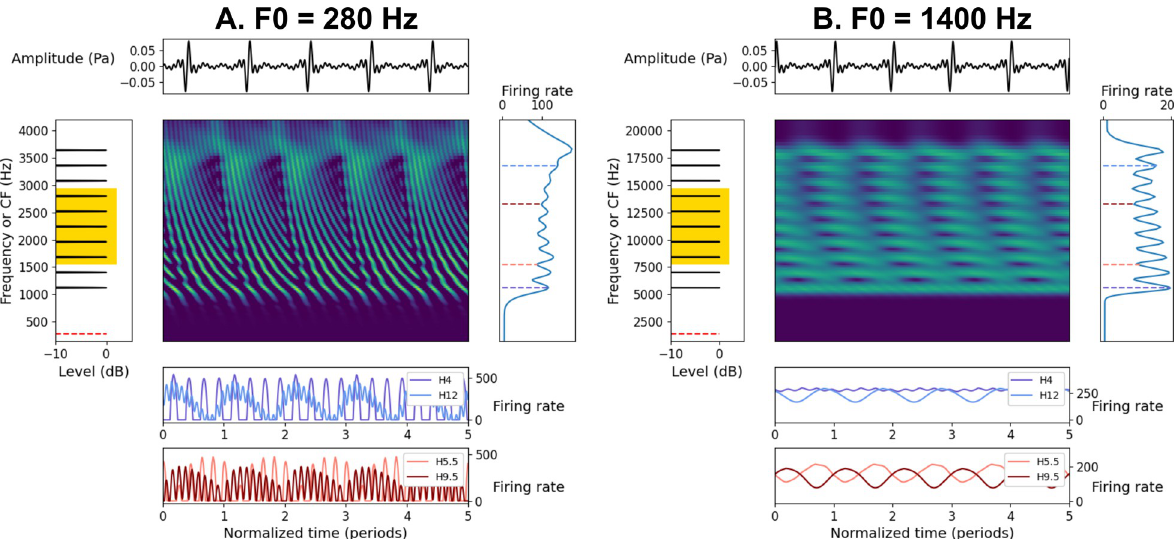
Fig 1. Representation of complex tones in a simulated auditory nerve. (A). Simulated responses of a population of high-spontaneous-rate auditory-nerve fibers [52] for five periods of a sine-phase HCT composed of harmonics 4–13 at a level of 50 dB SPL per component and an F0 of 280 Hz. The middle panel shows a “neurogram”, or a plot of instantaneous firing rate as a function of time and characteristic frequency. In the neurogram, color (from purple [low] to yellow [high]) indicates the instantaneous firing rate analogous to color indicating intensity in a spectrogram. The top and left panels show the temporal waveform and spectrum, respectively, of the acoustic stimulus. In the left panel, the yellow box highlights the frequency ranges used in the behavioral experiments. The bottom two panels and right panels show the responses of individual nerve fibers over time and the response profile averaged over time, respectively, of the simulated neural response. The bottom two panels show responses for auditory- nerve fibers tuned to component frequencies (4F0, purple; 12F0, blue) or tuned between component frequencies (5.5F0, pink; 9.5F0, maroon). (B). Same as A, except for an F0 of 1400